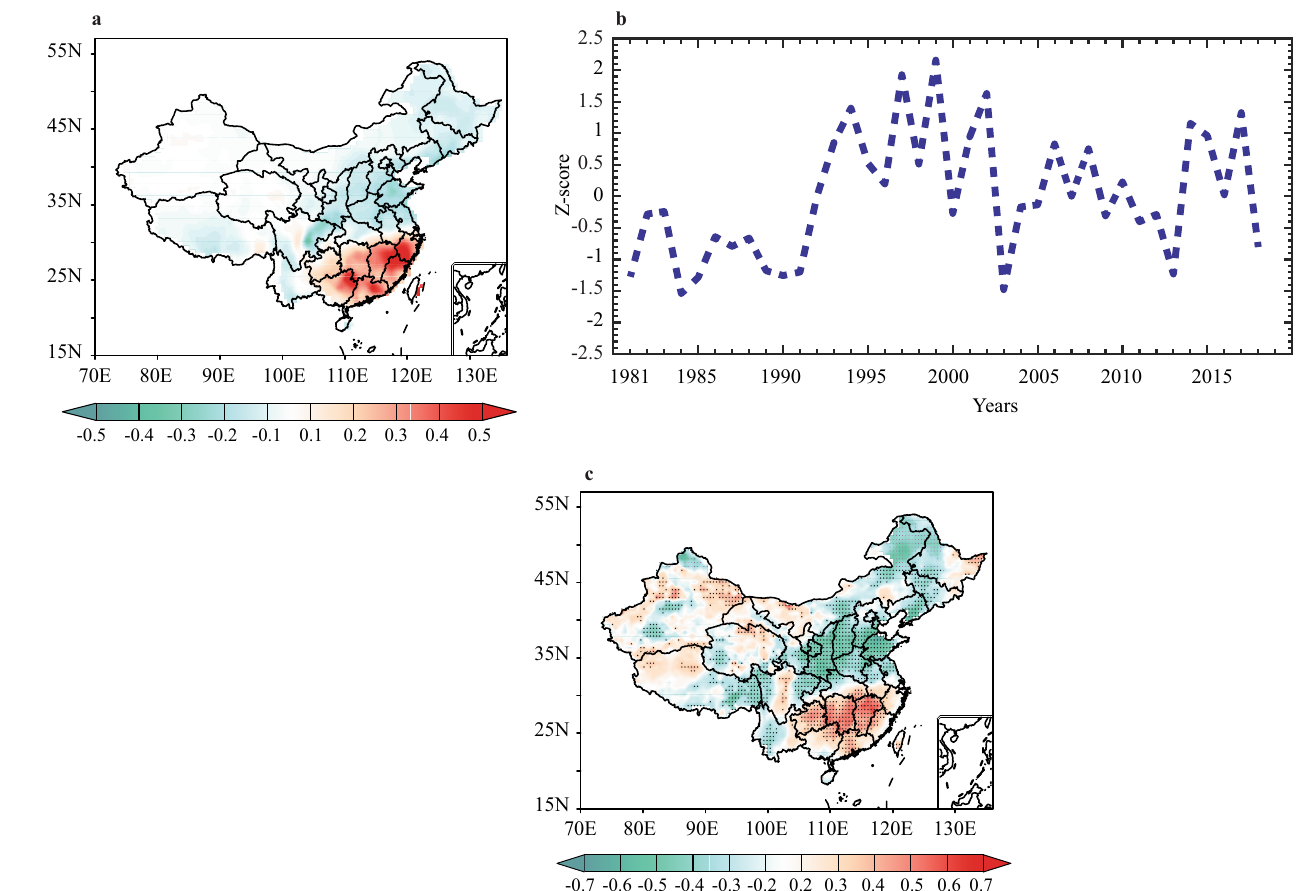
Fig. 1 Spatiotemporal JJA precipitation variability and its relationship with soil moisture. The a EOF eigenvectors and the b leading principal component (PC1) of the JJA precipitation from 1981 to 2018. The c pixel-wise correlation of the PC1 and JJA SM during 1981-2018. The dotted regions have passed the signi fi cance test with a 95% con fi dence